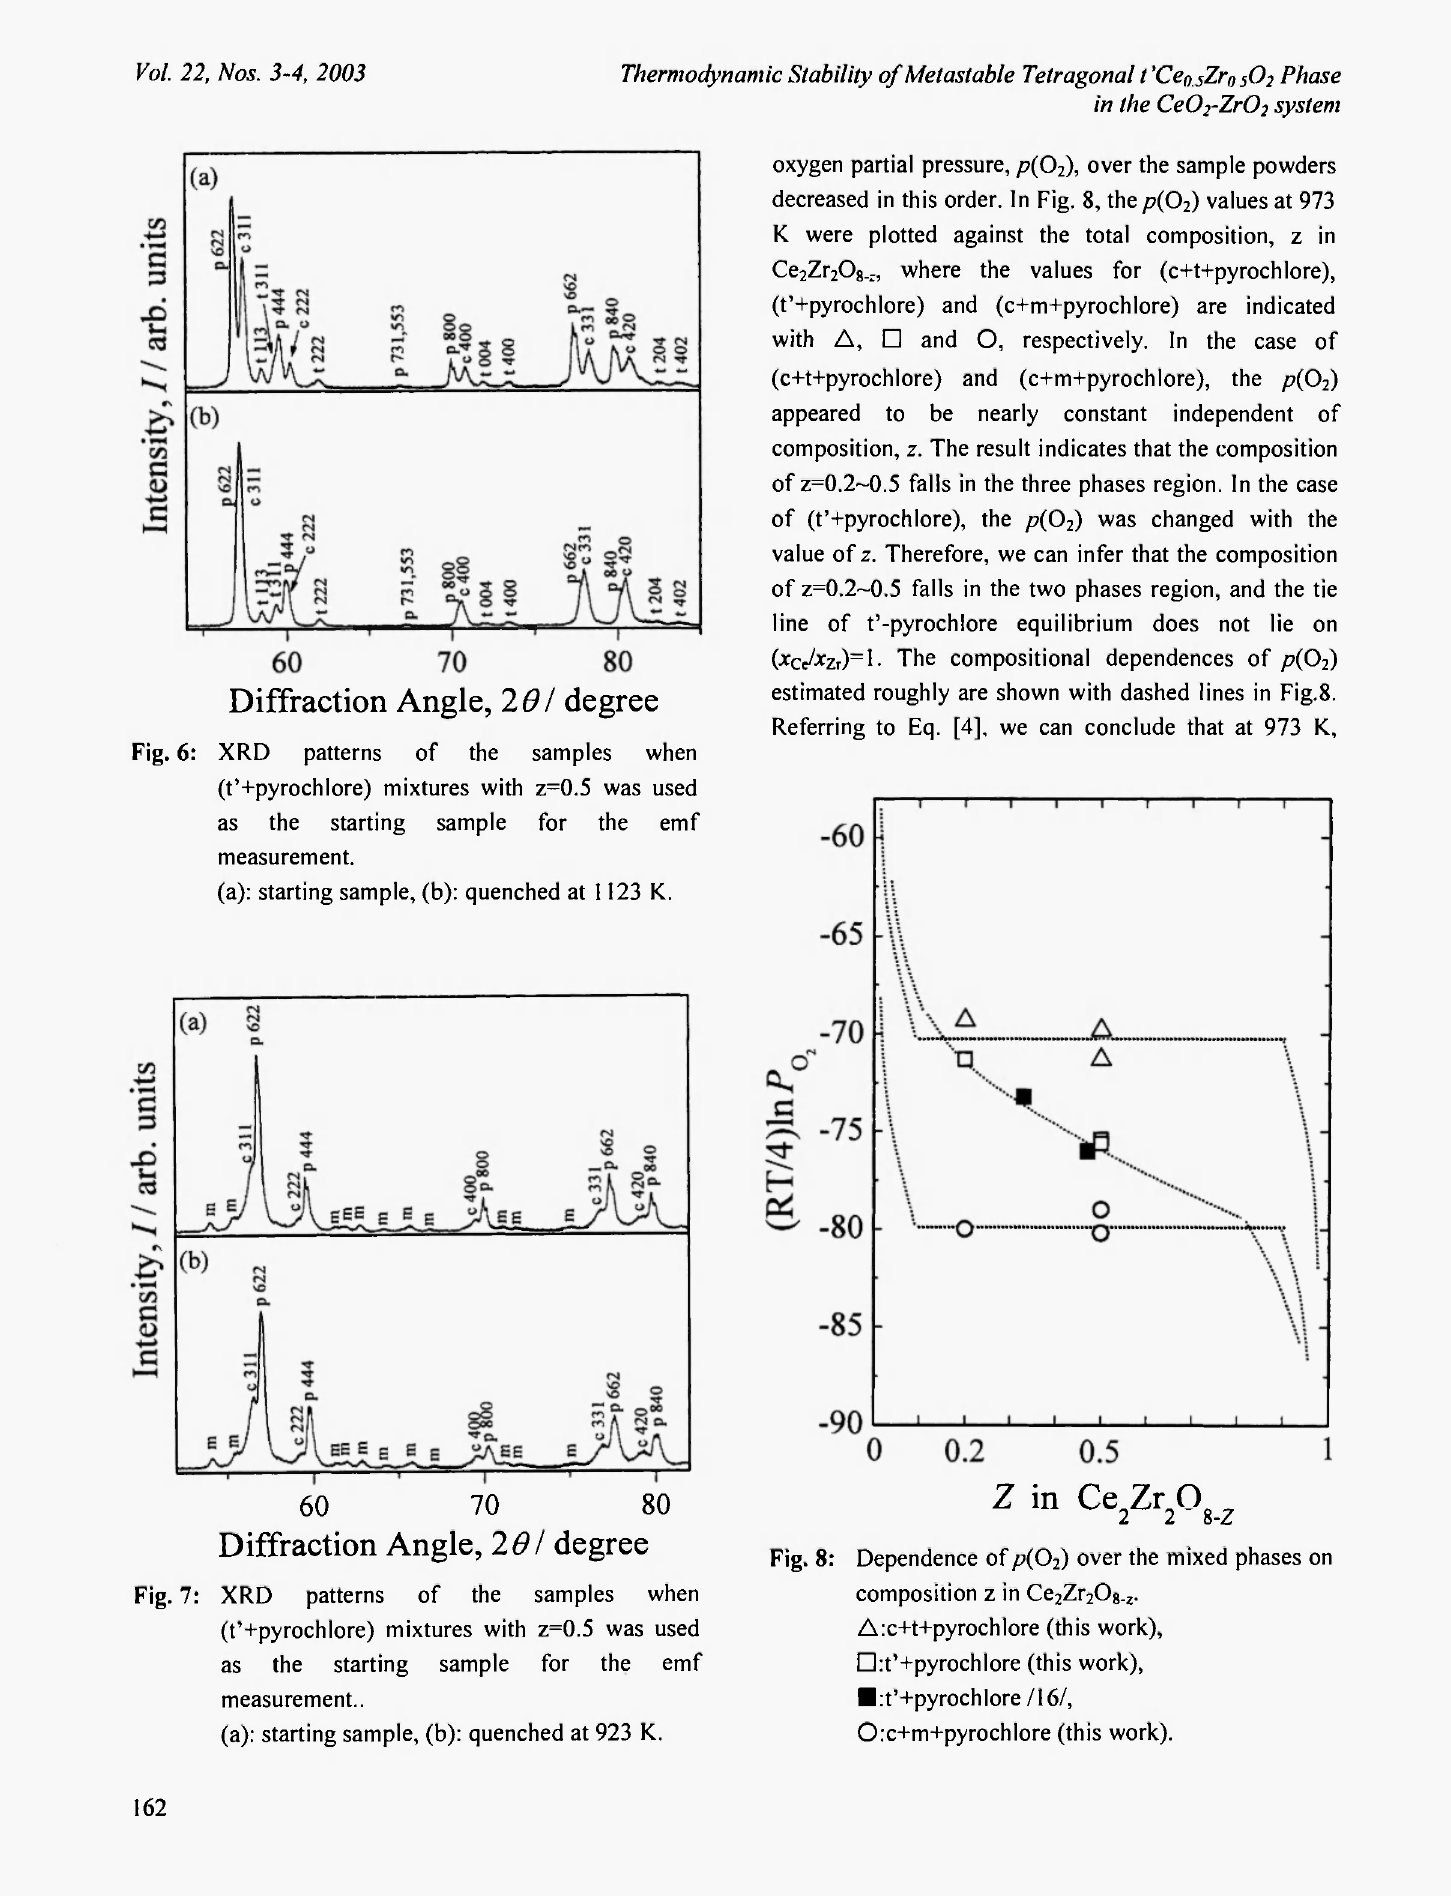
Fig. 8: Dependence of ^(0 2 ) over the mixed phases on composition ζ in Ce 2 Zr 2 08. 2 . Δχ+t+pyrochlore (this